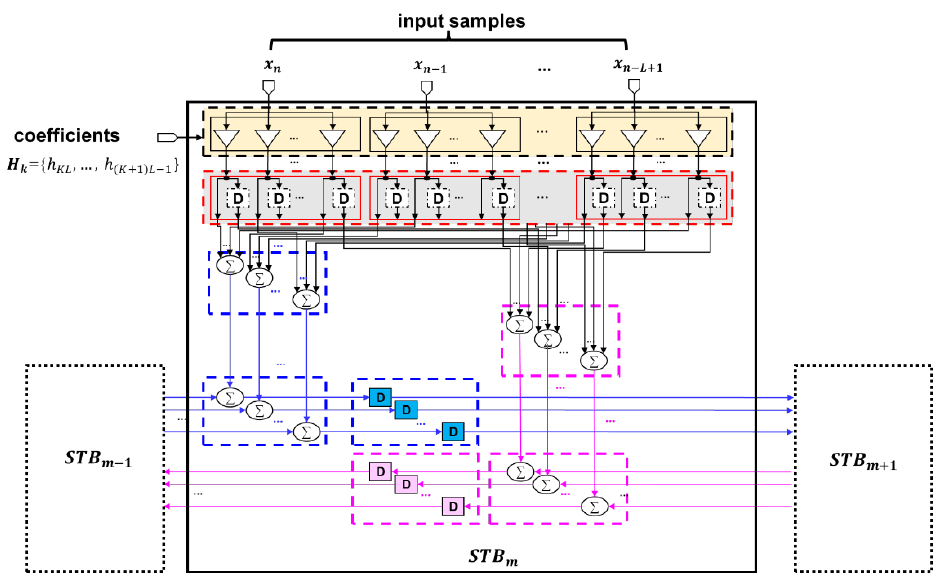
Figure 6. STB design in the proposed STB-FIR.